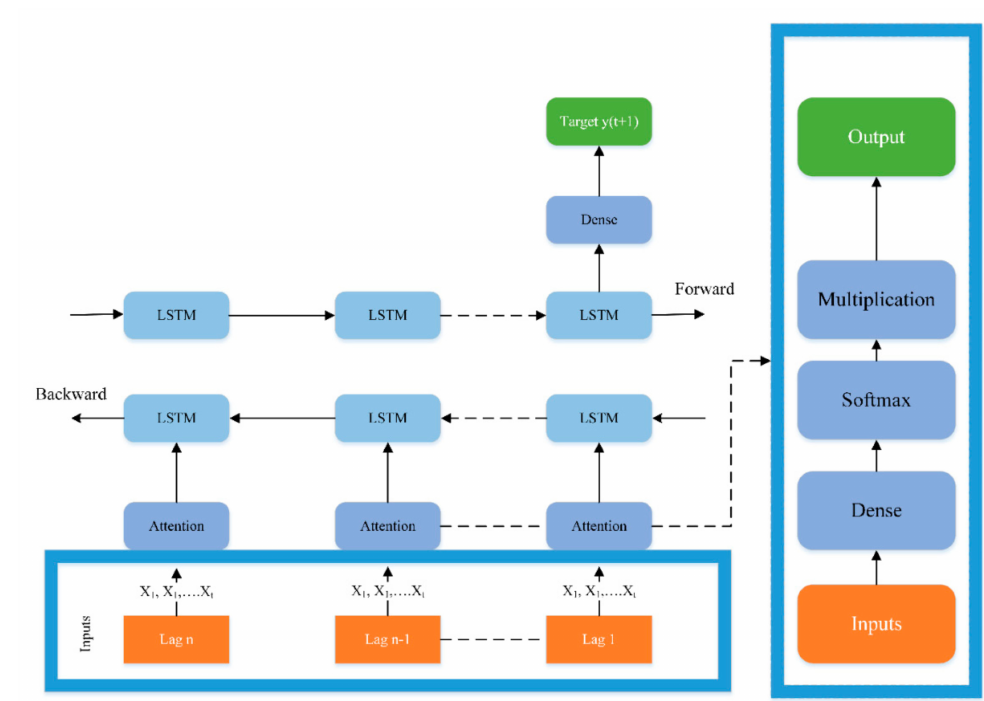
Figure 1. Architecture of bidirectional LSTM network with attention